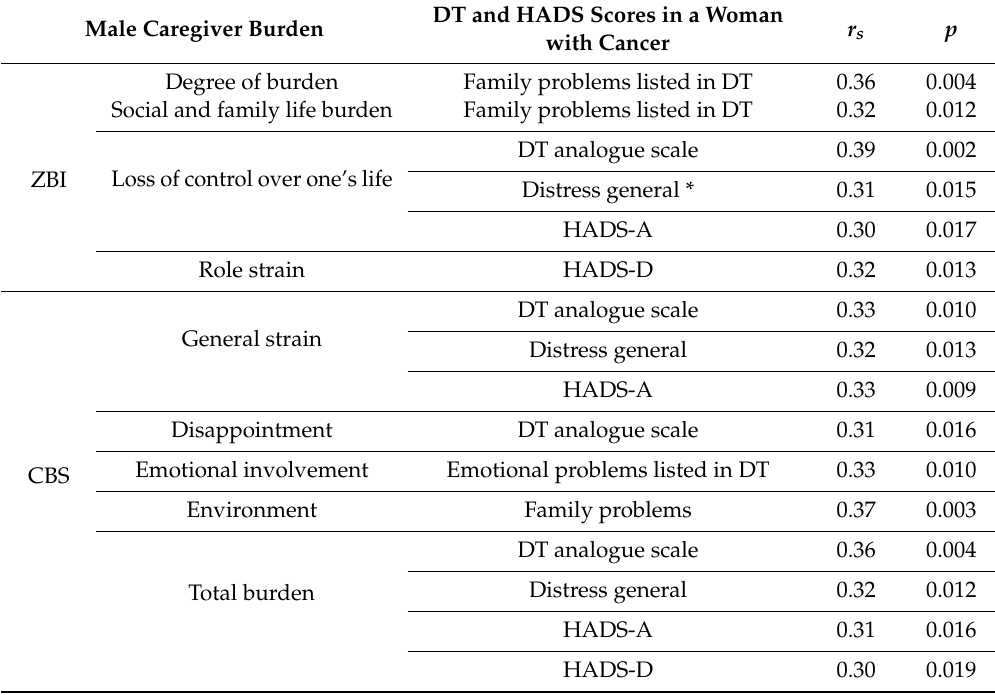
Table 4. Analysis of the correlation between the burden of the male caregivers, anxiety, and depression, and stress in a woman with